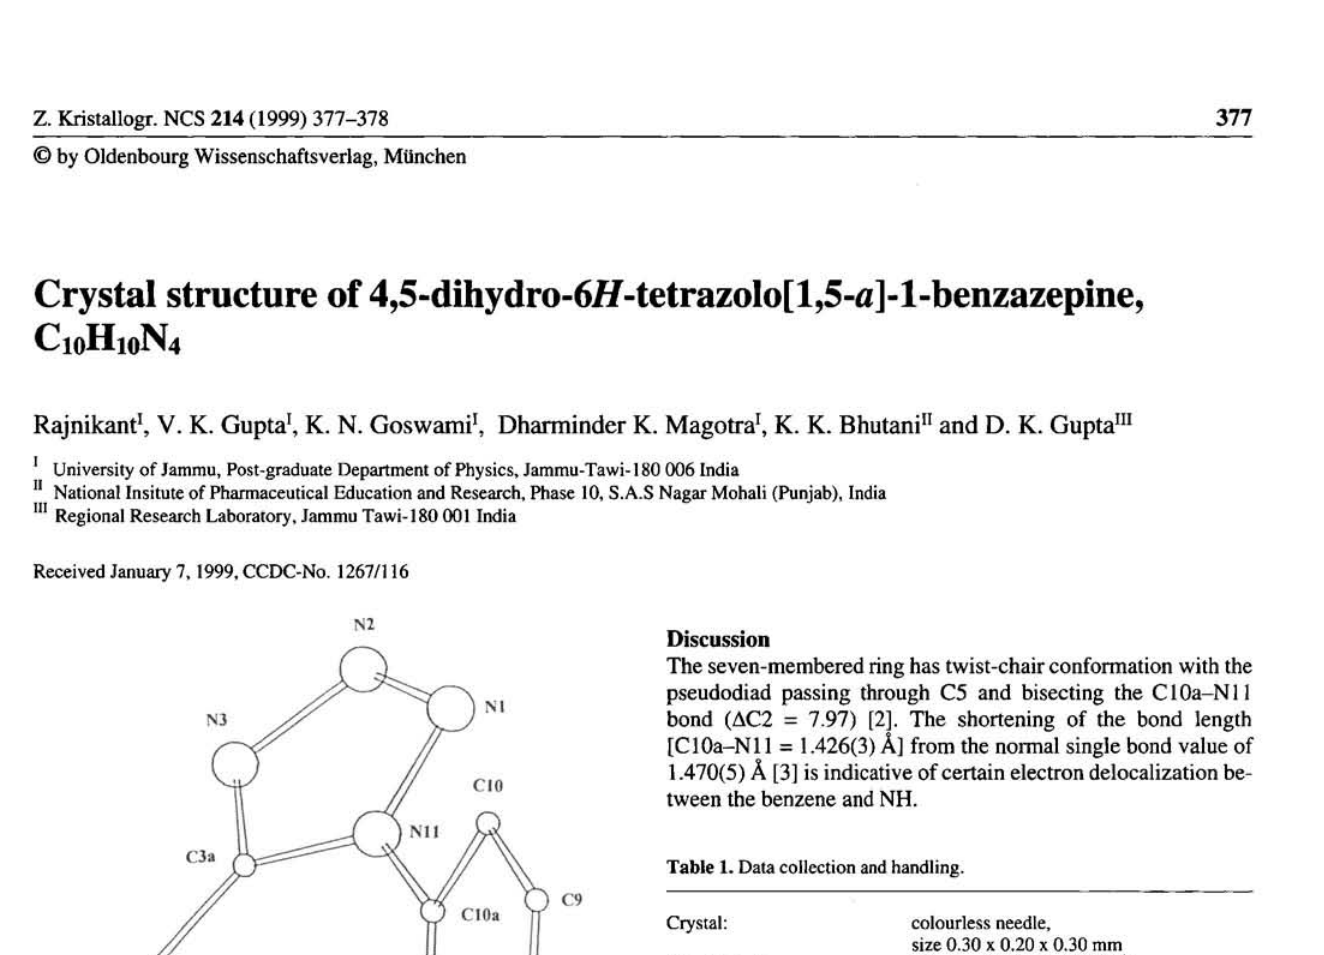
Table 2. Atomic coordinates and displacement parameters (in Â 2 ).